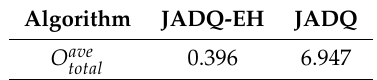
Table 8. C ave comparison of JADQ-EH and JADQ under scenario 1. total